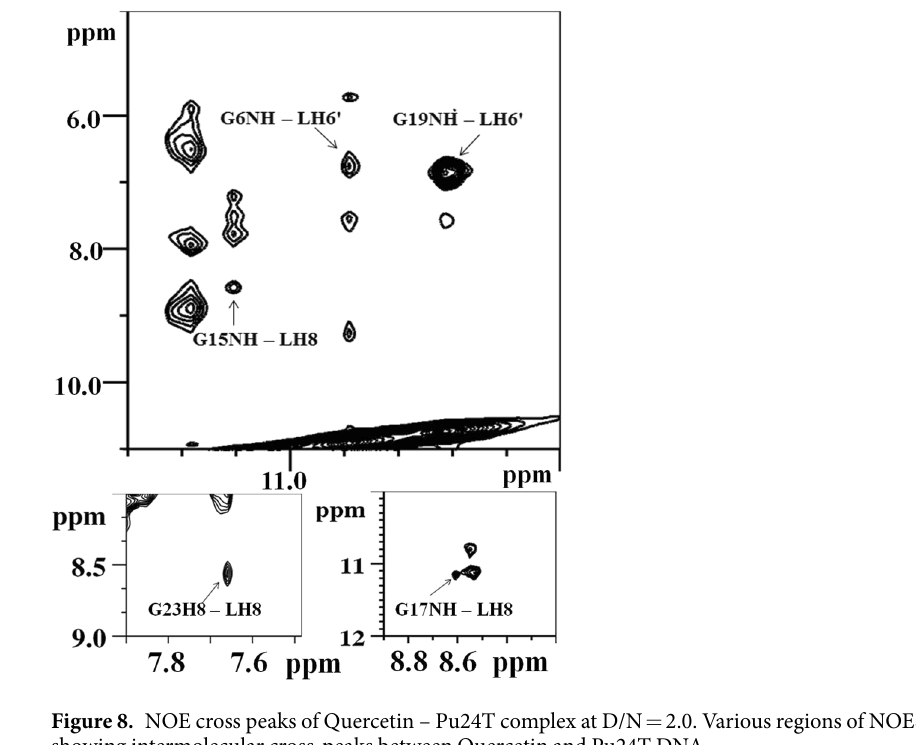
Figure 8. NOE cross peaks of Quercetin – Pu24T complex at D/N = 2.0. Various regions of NOESY spectrum showing intermolecular cross-peaks between Quercetin and Pu24T